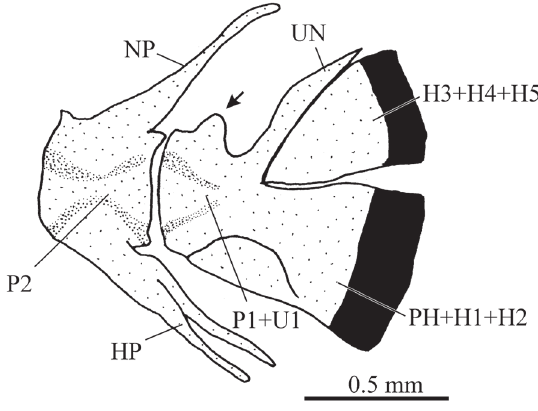
Fig. 4. Caudal skeleton of Listrura camposi , MNRJ 37023, 35.7 mm SL, left side: lateral view. The arrow indicates the vestigial neural arch of preural-1 centrum. Legends: H3+H4+H5 - fused hypural 3-hypural 4-hypural 5, HS - hemal